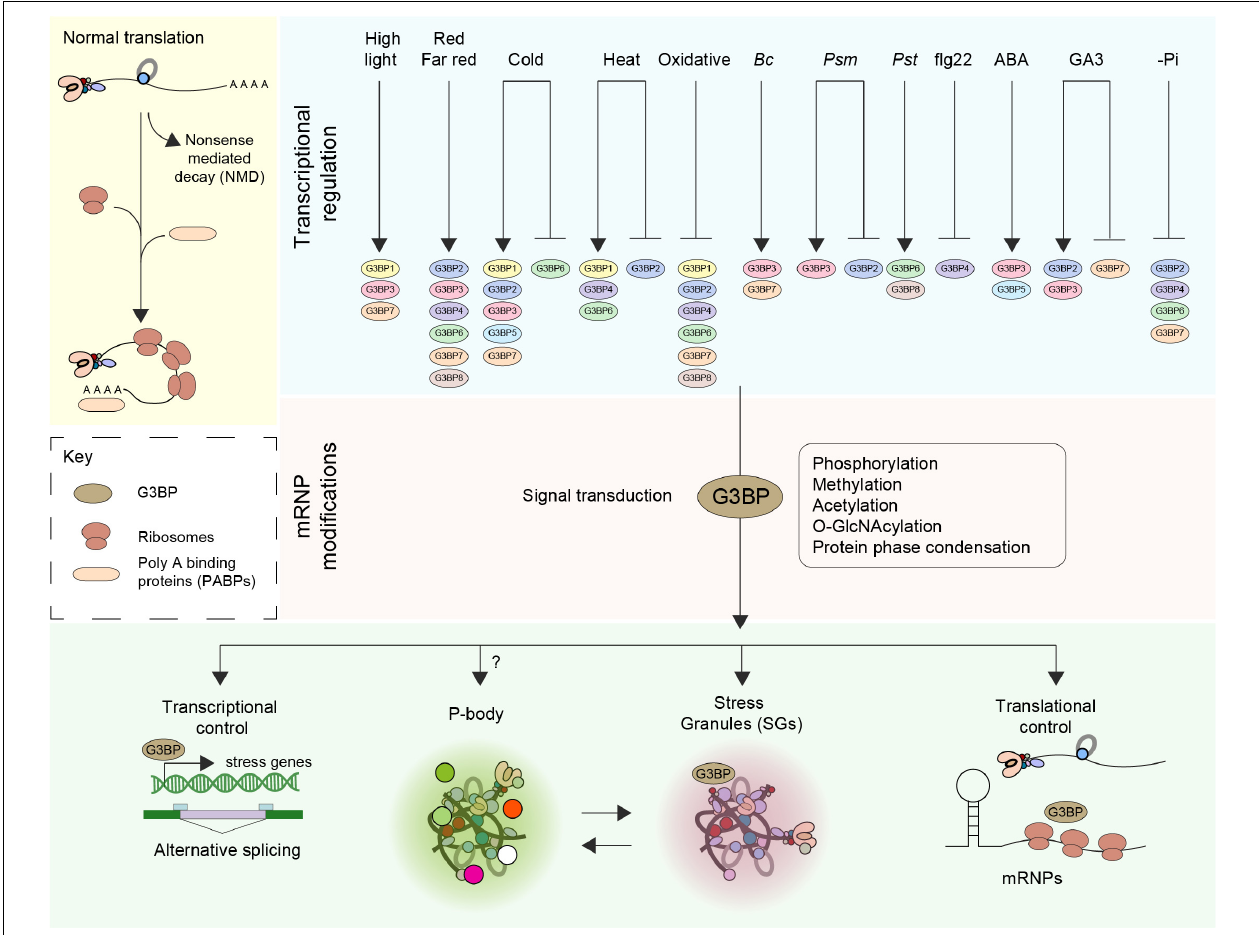
FIGURE 1 | Function and regulation of G3BPs. The fate of mRNA is delicately balanced by means of an equilibrium between translation, trafficking, storage and decay (Nonsense mediated decay–NMD). Perception of various external stress stimuli such as abiotic (light, cold, heat, and oxidative), biotic [ Botrytis cinerea ( Bc ), Pseudomonas syringae maculicola ( Psm ), Pseudomonas syringae pv. Tomato DC3000 ( Pst )] stresses, elicitors [the flagellin peptide (flg22)], hormones (ABA, GA3) and nutrient starvation (-Pi) results in transcriptional induction or repression of G3BPs. A log2 Fold change > ± 1 was considered. Stresses induce the disassembly of polysomes, thereby freeing mRNAs and mRNPs. The subsequent steps in the signal transduction pathway involve posttranslational modification such as phosphorylation, methylation, acetylation and O-GlcNAcylation of mRNPs. An increase in the pool of translationally inactive mRNA favors the assembly of SG orchestrated by G3BPs. The G3BPs then exert transcriptional control by altering gene expression and/or alternative splicing or by inducing the formation of stress granules (SGs) thereby controlling translation. SGs disassemble when the organism adapts to stress or when the stress is relieved, facilitating the restoration of normal